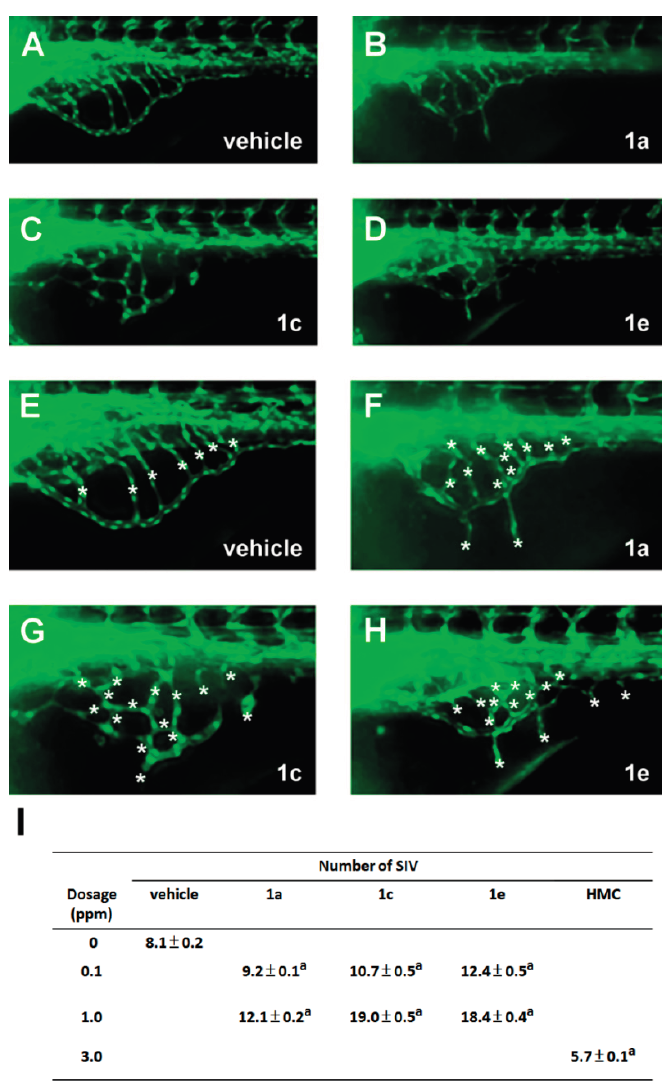
Figure 4. Chalcone derivatives caused pro-angiogenic effect on the zebrafish transgenic line Tg( fli1:egfp ). ( A – D ) Representative images of fluorescent SIV basket of embryos treated with water containing 0.12% DMSO (vehicle) or chalcones derivatives (in 0.12% DMSO) via exposure method II. The fluorescent vessels of embryos were observed at 72 hpf; ( E – H ) Enlarged SIV regions in ( A – E ). The number of SIV was defined as the sum of the number of vessel within the SIV plus the number of angiogenic outgrowth sprouts (marked by asters); ( I ) Data are the mean ± S.D. of twenty embryos from three independent experiments ( n = 60 in each group). A t -test with 0.05 of significance level, carried out by JMP statistical software (version 4.02), was used to assess the difference in the number of SIV between two groups. The result reported the number of SIV for all experiment groups are significantly different from vehicle group ( a : p <